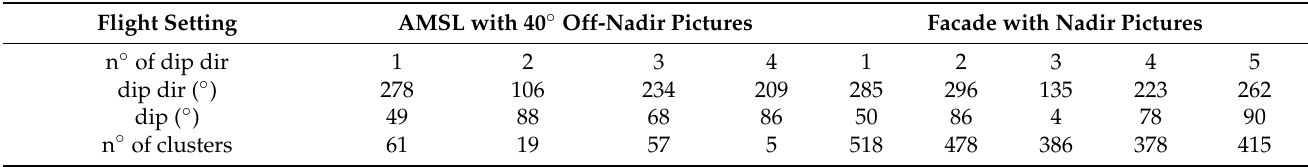
Table 5. Comparison of the discontinuity orientations and clusters detected in two topographies using the Discontinuity Set Extractor software. Flight Setting AMSL with 40 ◦ Off-Nadir Pictures Facade with Nadir